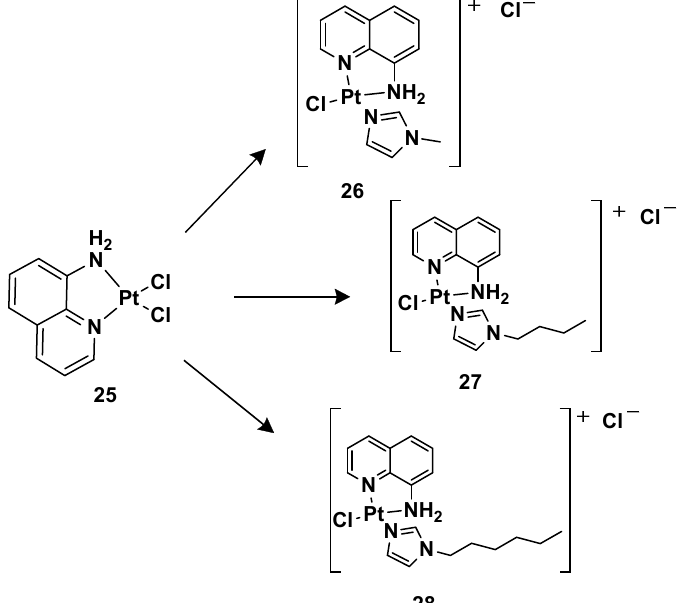
Figure 12. Synthesis of cationic platinum(II) complexes, 25 – 28 . Modifying the ligand causes a different biological effect in the corresponding cationic platinum(II) complexes. These differences are principally found in the accumulation of the complexes in different cellular phases, which results in a different effect on DNA: they seem to arrest cells into a G0/G1 phase to a greater extent; they more efficiently induce p53 mRNA; and α -tubulin and β -actin levels significantly reduce in response to new platinum(II) complexes. Furthermore, it should be highlighted that 28 is the most potent cytotoxic agent of this series against the triple-negative breast cancer MDA-MB-231, a particularly aggressive tumor still lacking effective chemotherapeutic treatments. For this reason, 28 ( Pt-8AQ ) has been further analyzed against six tumor cell lines. Three cell lines of human glioblastoma were present, i.e., U87-MG (expressing wild-type p53), U373-MG, and U138-MG (expressing endogenous mutant p53) [42]. Complex 28 shows higher activity against glioblastoma cells compared with cisplatin, with IC 50 values of 3.68, 11.53, and 8.05 µ M against U87-MG, U373-MG, and U138-MG, respectively, compared with cisplatin, which shows IC50 values of 7.27, 22.69, and 32.1 µ M against U87-MG, U373-MG, and U138-MG, respectively, while they had a similar effect on pancreatic adenocarcinoma CFPAC-1, mesothelioma MSTO-211H, and